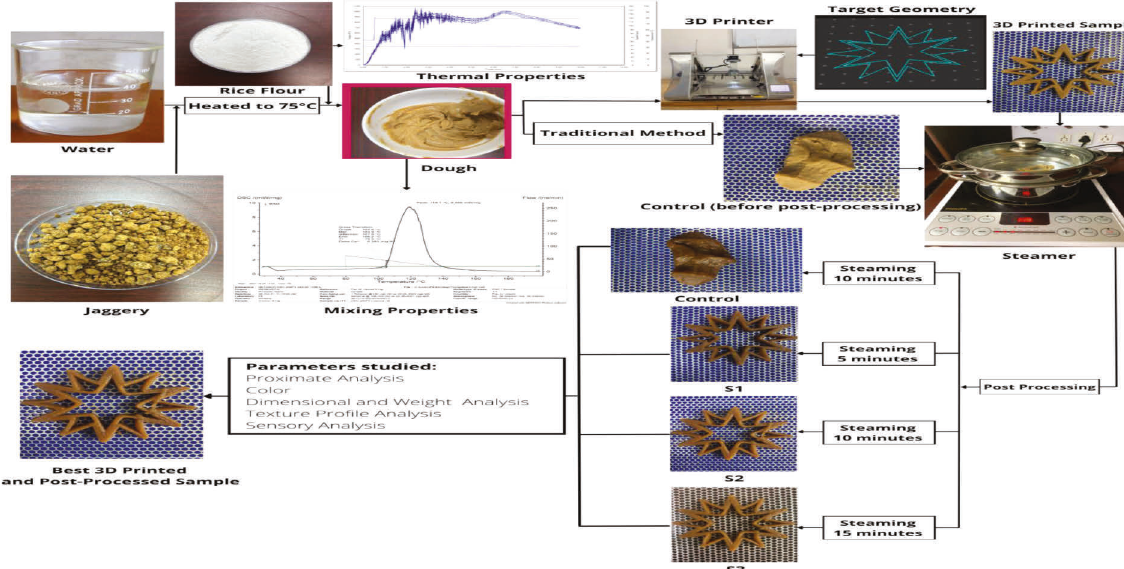
Figure 1: Experimental plan adapted for this investigation and the target